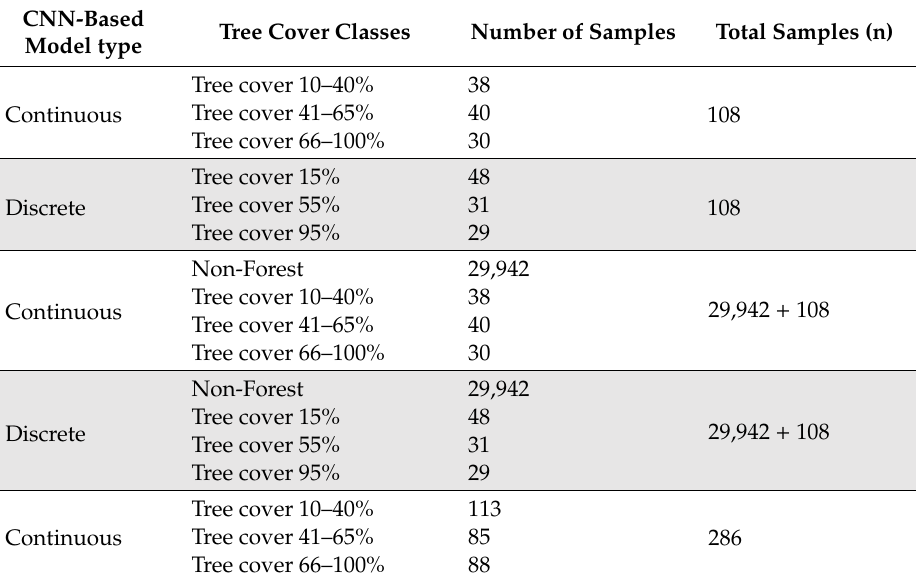
Table 1. Five datasets created considering continuous or discrete training strategy for the forest classes and with or without the “Non-Forest” class. In the continuous strategy, the forest classes were: Open Forest with tree cover 10–40%, Closed Forest with tree cover 41–65%, and Dense Forest with tree cover 66–100%. In the discrete strategy, the forest classes were: Open Forest with tree cover 15%, Closed Forest with tree cover 55%, and Dense Forest with tree cover 95%). Number of samples (plots) used to train the CNN-based models (third column). See Table S1 in Supplementary Material for more information about the images used in the